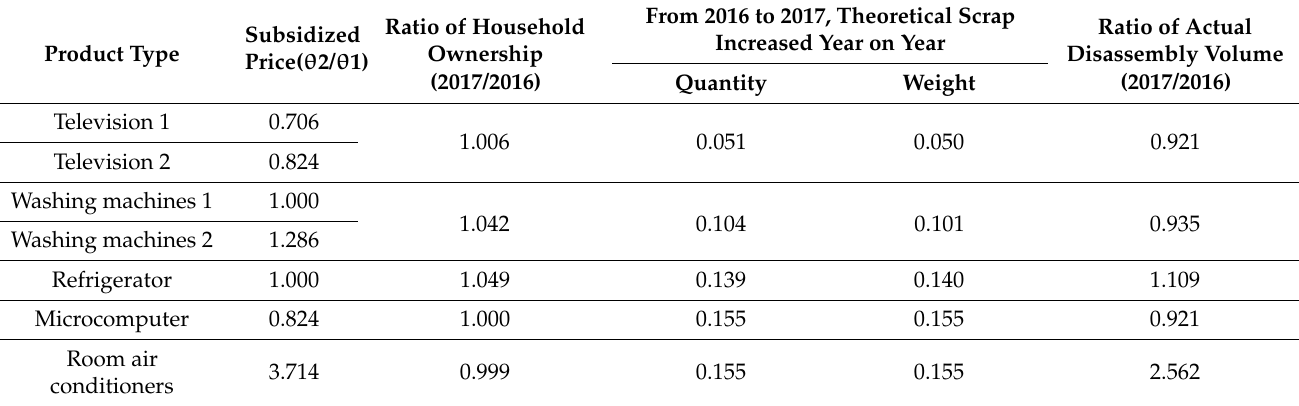
Table 4. Changes in retention, scrap and disassembly in